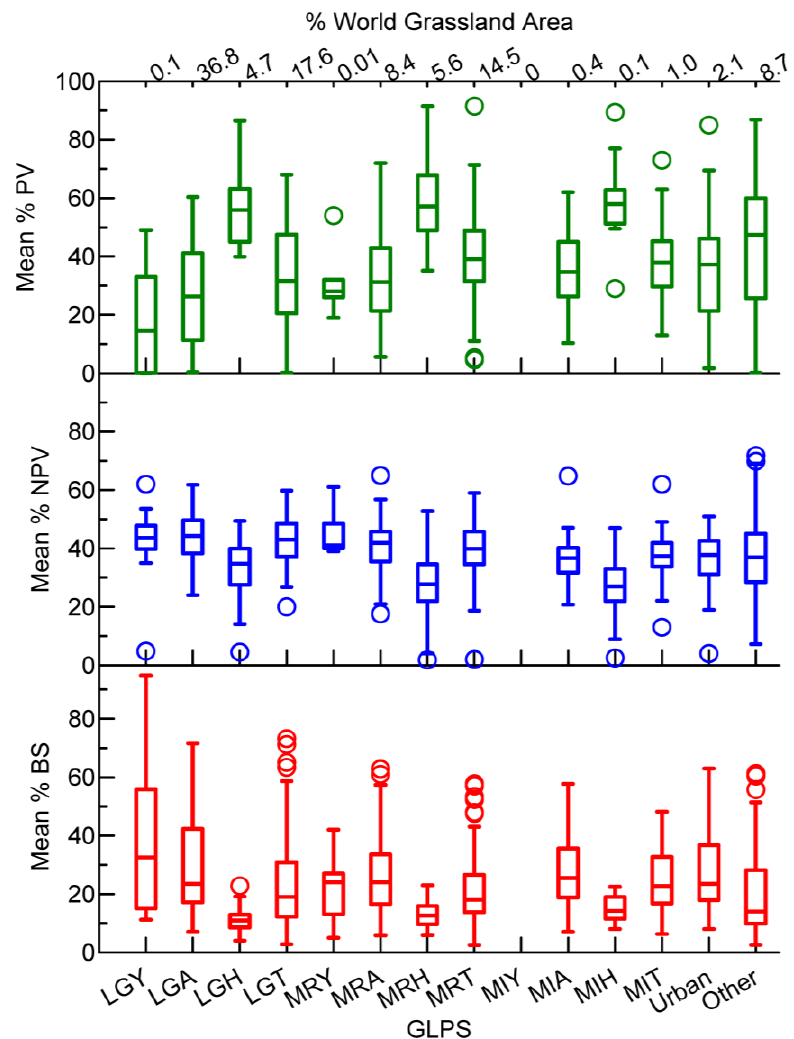
Figure 3. Global latitudinal variation in average fractional cover of F PV , F NPV , and F BS .